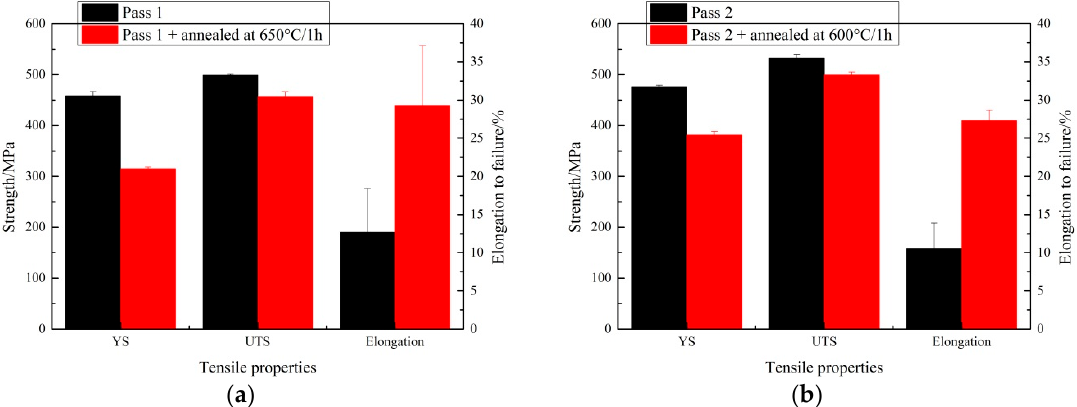
Figure 10. Tensile properties of CGP nickel sheets before and after post-deformation annealing: ( a ) Pass 1; ( b ) pass 2.